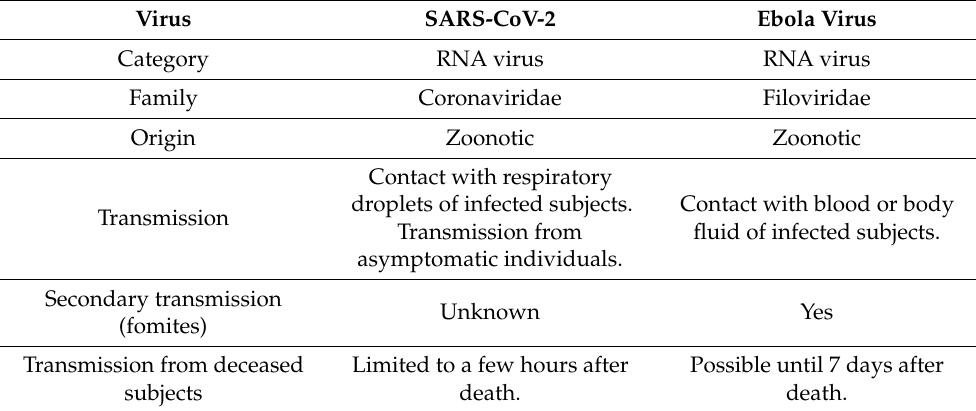
Table 2. The main differences between SARS-CoV-2 and the Ebola